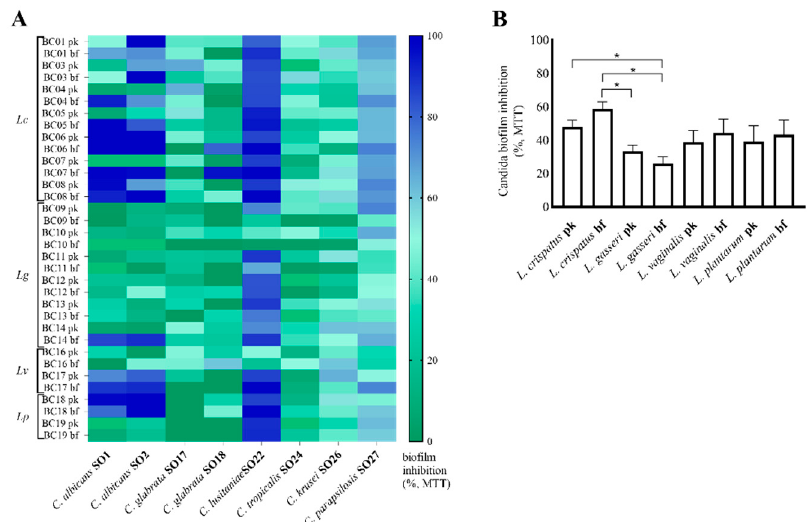
Figure 3. Inhibition of Candida isolate biofilm formation by lactobacilli pk-CFS and bf-CFS, evaluated by MTT assay. ( A ) Heatmap of biofilm inhibition percentage, calculated over corresponding Candida growth control, ( B ) average ± SEM of biofilm inhibition percentages, grouped for Lactobacillus species and mode of growth (pk/bf). Lc, Lactobacillus crispatus ; Lg, Lactobacillus gasseri ; Lv, Limosilactobacillus vaginalis ; Lp, Lactiplantibacillus plantarum . * p < 0.05 (ANOVA).